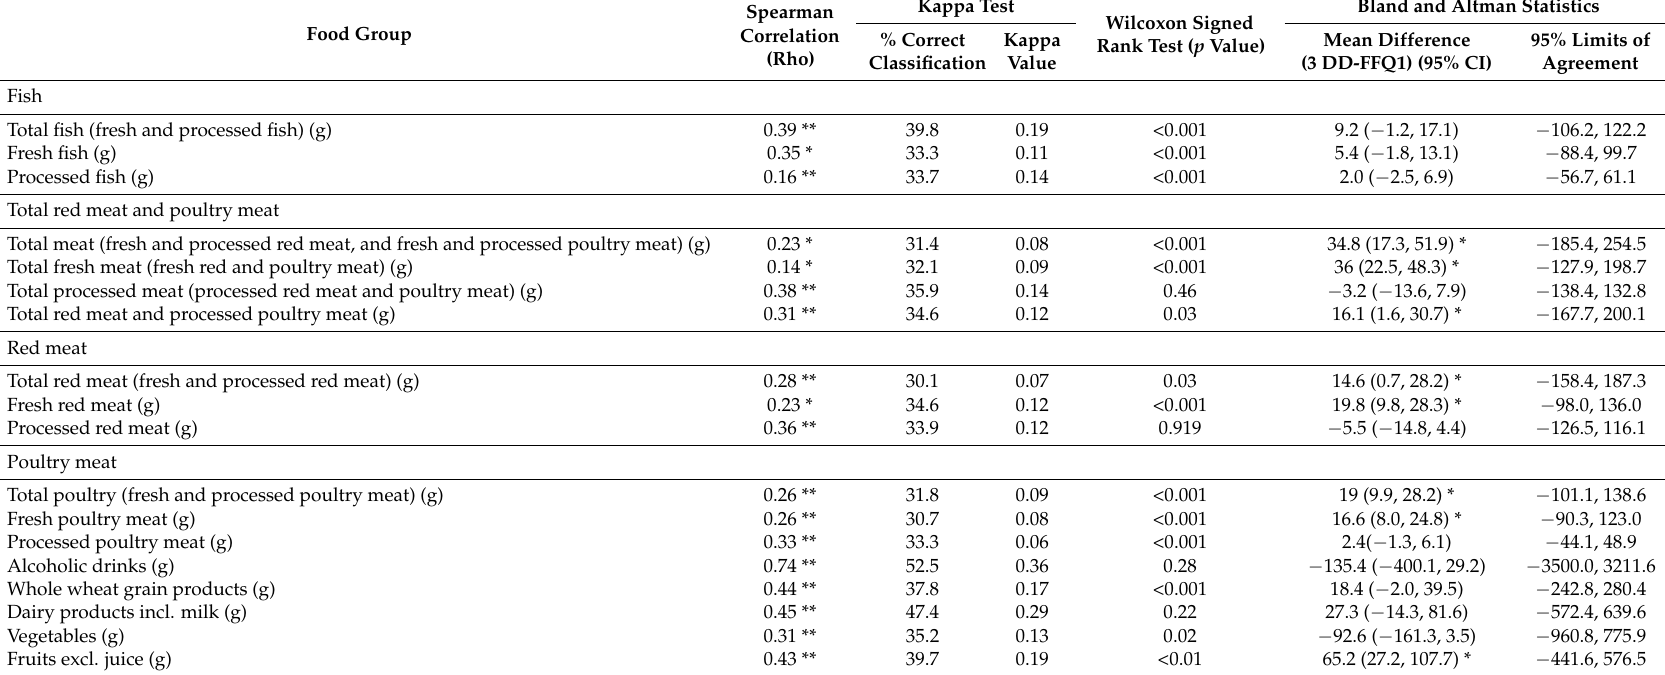
Table 4. Relative validity of food and nutrient intake when comparing the FFQ to the 3-day dietary record ( n =